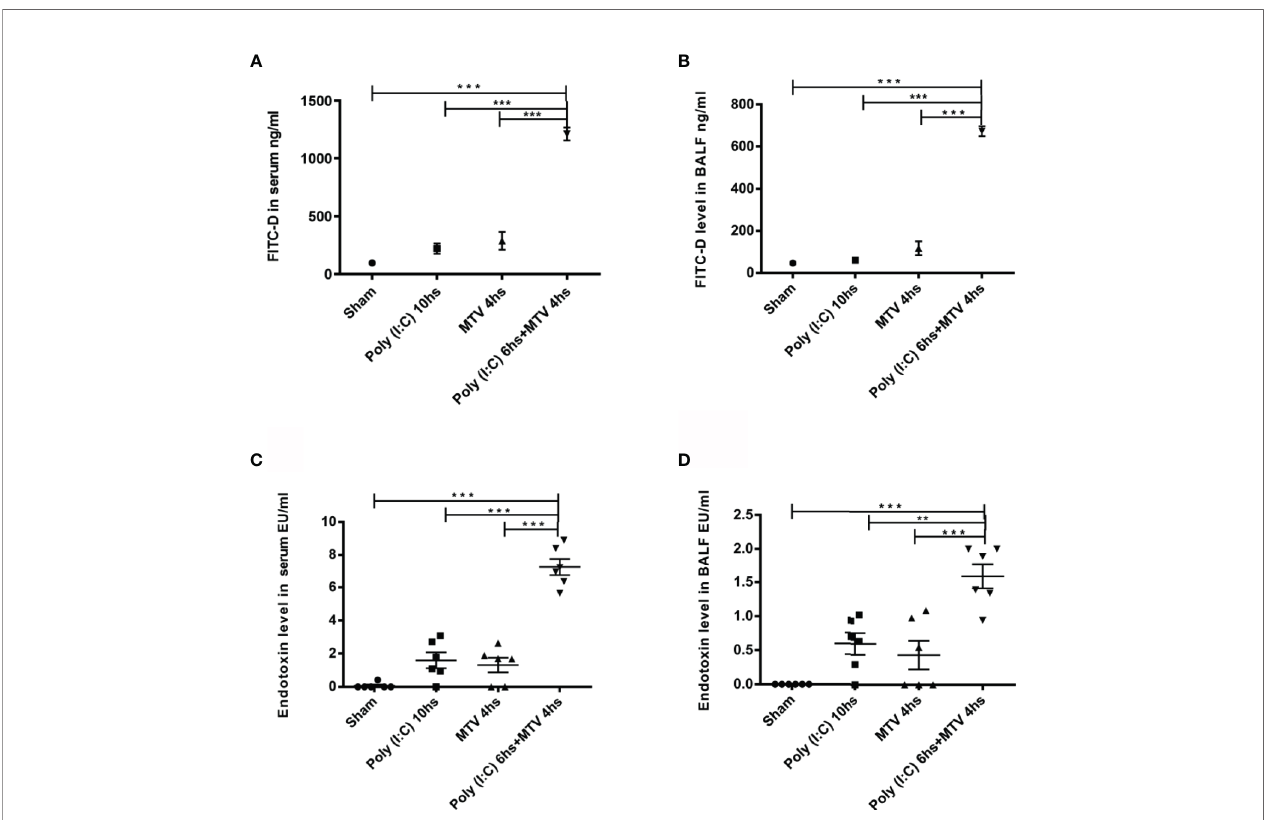
FIGURE 1 | Intestinal and alveolar-capillary permeability. Intestinal permeability of mice evaluated by FITC-D levels in serum (A) and in bronchoalveolar lavage fl uid (BALF) (B) 200 µL FITC-D (30 mg/mL) was instilled through orogastric feeding. Endotoxin levels in serum (C) and in BALF (D) were measured. All PBS and Poly(I:C) used were endotoxin-free. Mice were divided into four groups treated with Sham as control, Poly(I:C), mechanical ventilation with tidal volume of 10mL/kg (MTV) and Poly(I:C) followed with MTV as indicated in the fi gure. Results are shown as means ± SEM (n=6) and compared by one-way ANOVA and Student-Newman-Keuls test. ** p < 0.01, *** p <